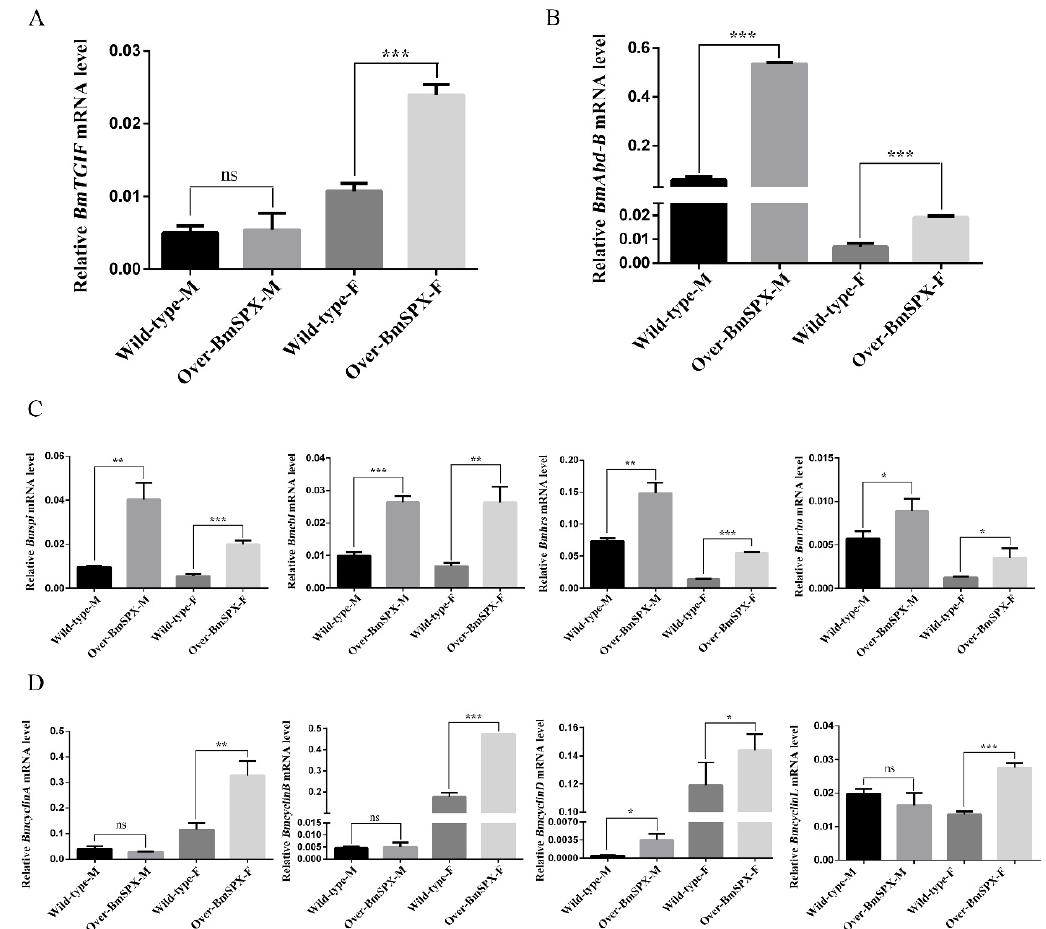
Figure 4. Expression levels of key factors in gonad development of Over-BmSPX transgenic strains. A value of p < 0.05 was considered to be statistically significant (* p < 0.05, ** p < 0.01, *** p < 0.001). ( A ) BmTGIF expression level in Over-BmSPX transgenic strains. ( B ) BmAbd-B expression level in Over-BmSPX transgenic strains. ( C ) Expression level of key factors, including in RTK, in Over-BmSPX transgenic strains. ( D ) Expression level of cyclin genes in Over-BmSPX transgenic strains. Wild-type-M and Wild-type-F indicate the male and female of wild type silkworm, respectively. Over-BmSPX-M and Over-BmSPX-F indicate the male and female of Over-BmSPX transgenic strains, respectively.